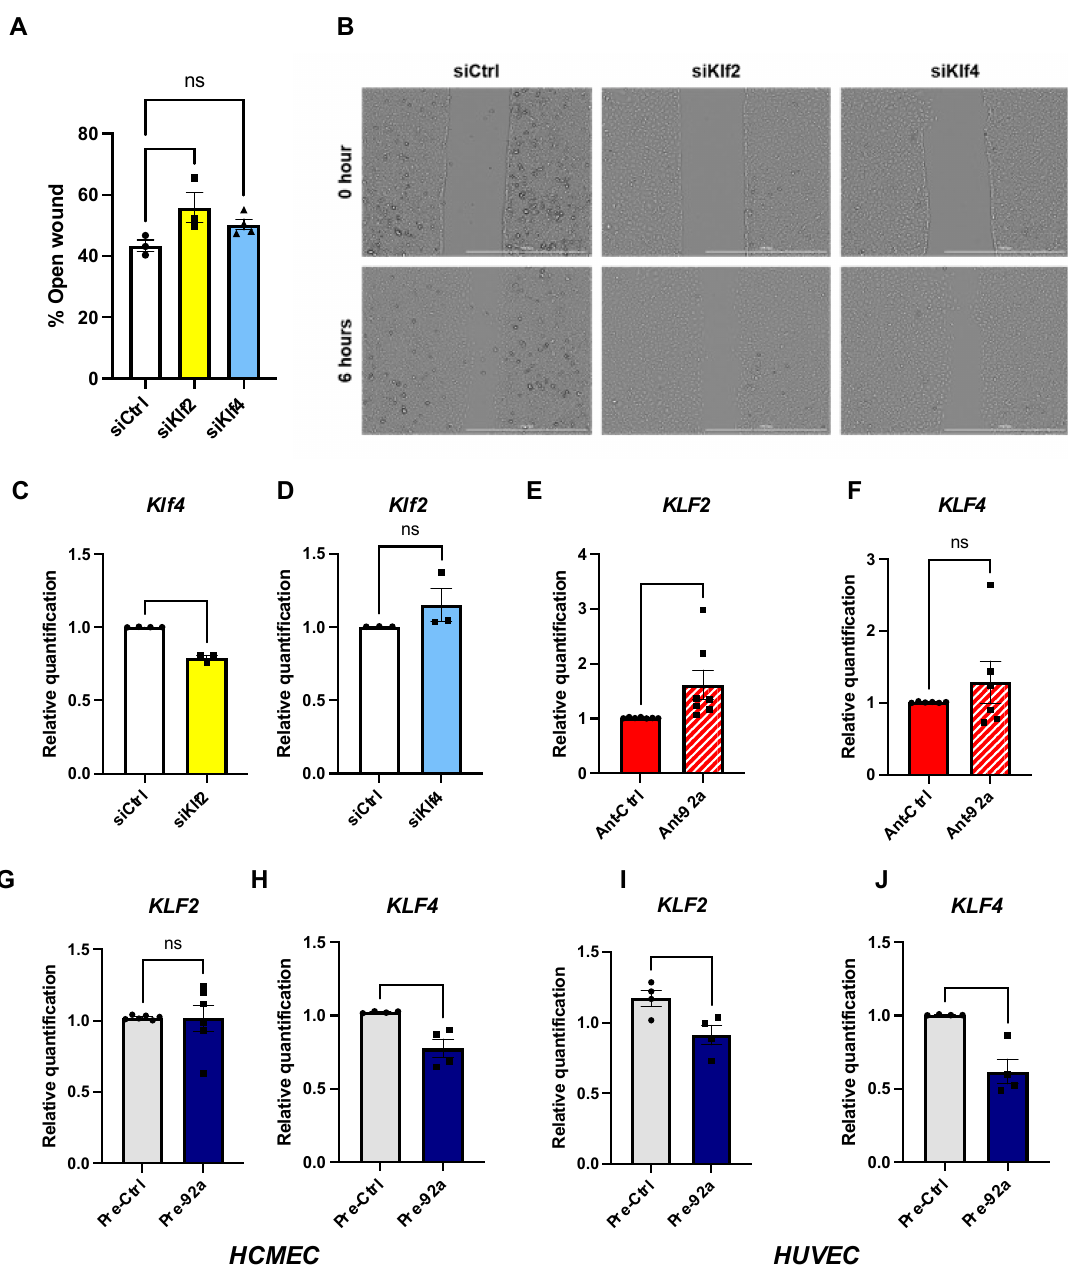
Figure 3. Effect and inter-regulation of KLF2 and KLF4 on CMEC function. ( A ) Analysis of 6-h open wound areas in percentage in MCMECs upon knockdown of Klf2 or Klf4 ( n = 4). ( B ) Bright field images using a Cytation 1 plate reader of MCMEC migration at 0 and 6 h upon knockdown of Klf2 . Scale bars equal 1 mm. Quantitative PCR analysis of ( C ) Klf4 gene expression upon knockdown of Klf2 in MCMECs and ( D ) Klf2 gene expression upon knockdown of Klf4 in MCMECs, each compared to respective controls ( n = 4). ( E , F ) Quantitative PCR analysis of ( E ) KLF2 and ( F ) KLF4 in diabetic HCMECs upon miR-92a inhibition by antagomir (Ant-92a) relative to controls (Ant-Ctrl) ( n = 6) and ( G ) KLF2 and ( H ) KLF4 in nondiabetic HCMECs upon miR-92a overexpression (pre-92a) relative to controls (pre-Ctrl) ( n = 4). ( I ,J) Quantitative PCR analysis of ( I ) KLF2 and ( J ) KLF4 in HUVECs upon miR-92a overexpression (pre-92a) relative to controls (pre-Ctrl). Statistical analyses by unpaired Student’s t -test or by one-way ANOVA ( n ≥ 4); * p < 0.05; ** p < 0.01; **** p <